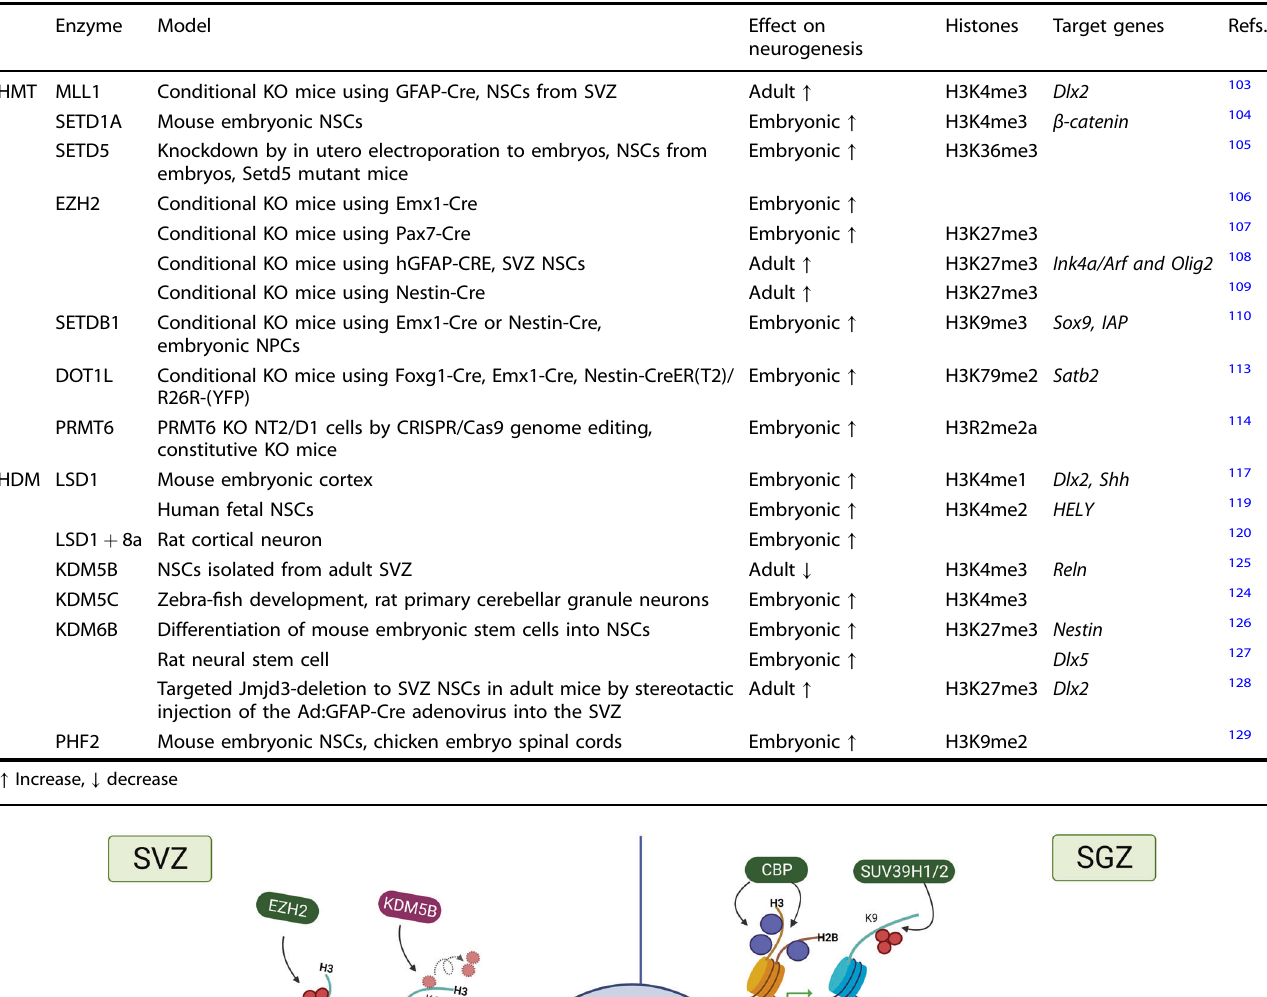
Histones Target genes Refs. neurogenesis